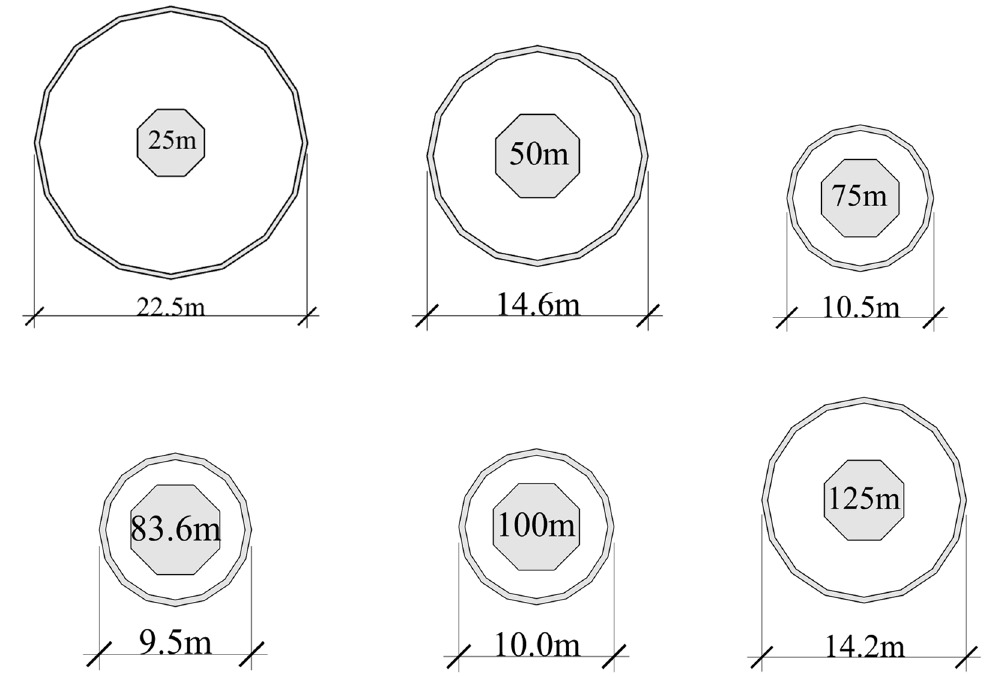
Figure 3. Arrangement of the measuring points on the 25 m layer and the definition of wind direc- tion angles.